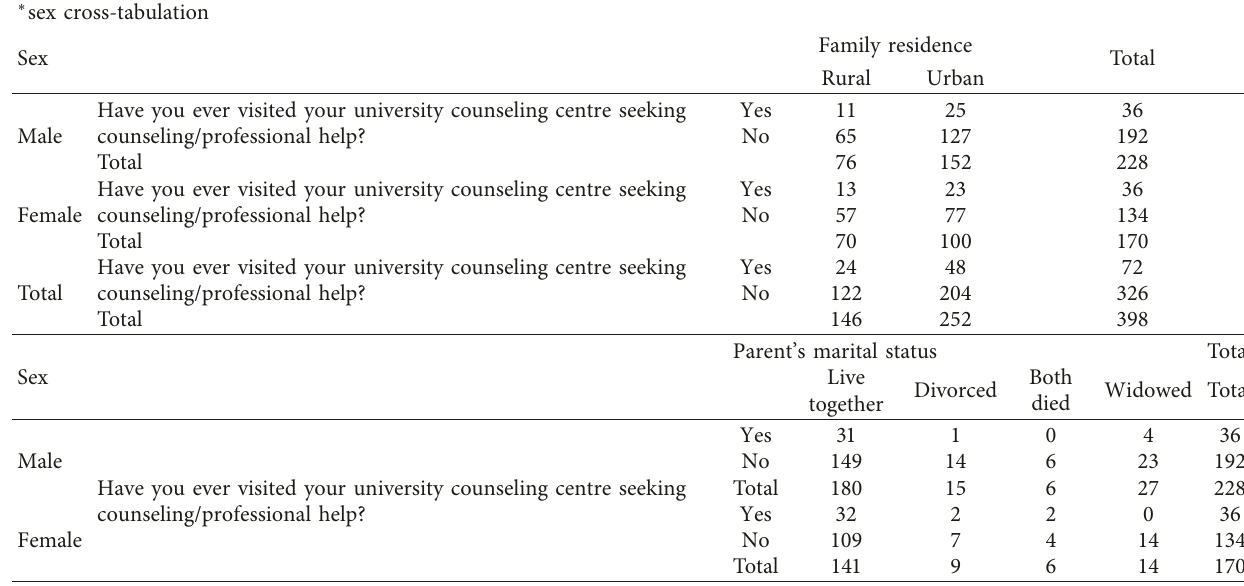
Table 4: Cross-tabulation result from the major factors that affect counseling needs of